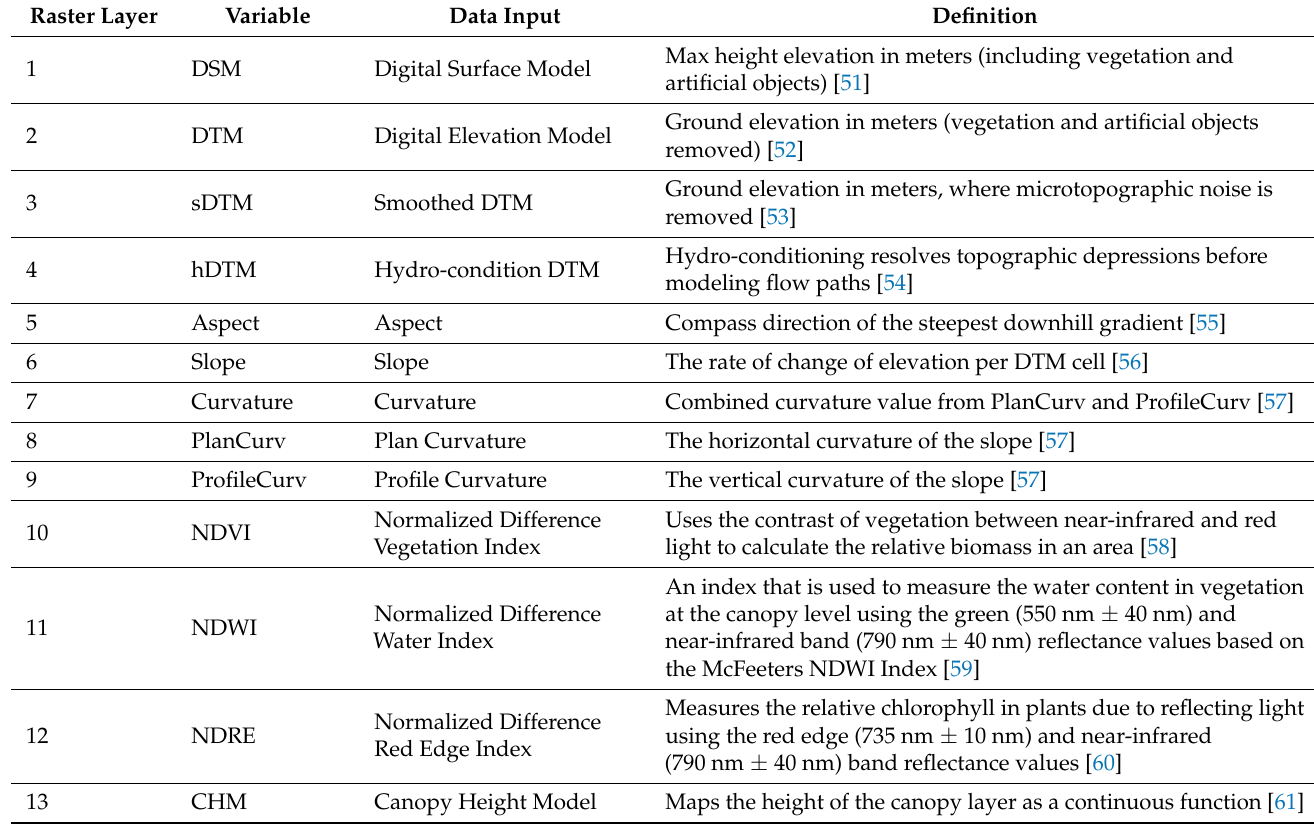
Table 2. Summary showing the predictors and response variables derived from the UAS-collected LiDAR and multispectral